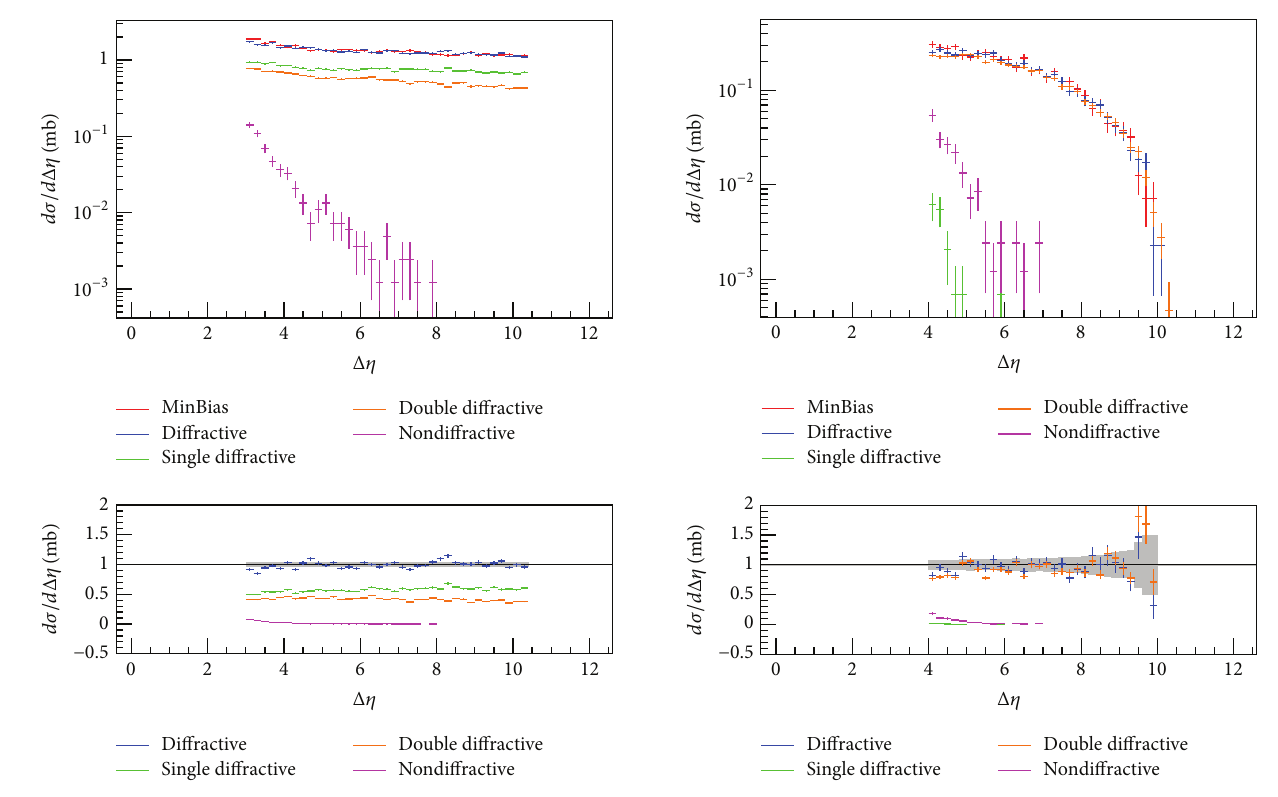
Figure 8: Large rapidity gap distribution for the events that have an edge gap Δ𝜂 > 3 with a cut of 𝑝 T > 200 MeV for all final state particles in |𝜂| < 5.2 . The MinBias event class is used as a reference for the ratio.